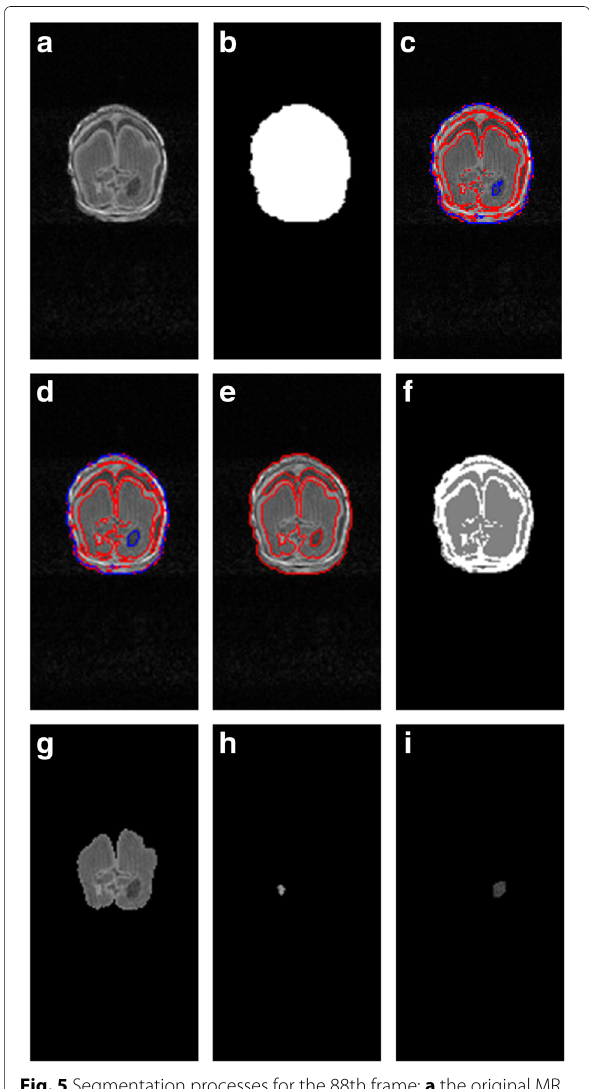
Fig. 5 Segmentation processes for the 88th frame: a the original MR image, b ROI, c contour after 10 iterations, d final contour after 50 iterations, f segmentation results, g one part segmented, h bright blob in MR image, and i dark blob in MR